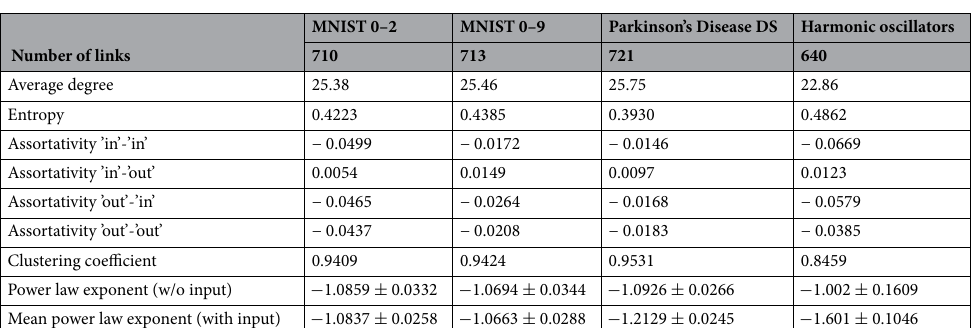
Table 1. Macroscopic characteristics of the interconnection graphs and criticality signatures of the trained networks for different tasks. The first three columns correspond to the STO network (3). The last column summarizes the training results for the network of identical harmonic oscillators under the MNIST-input (digits ’0’–’2’).